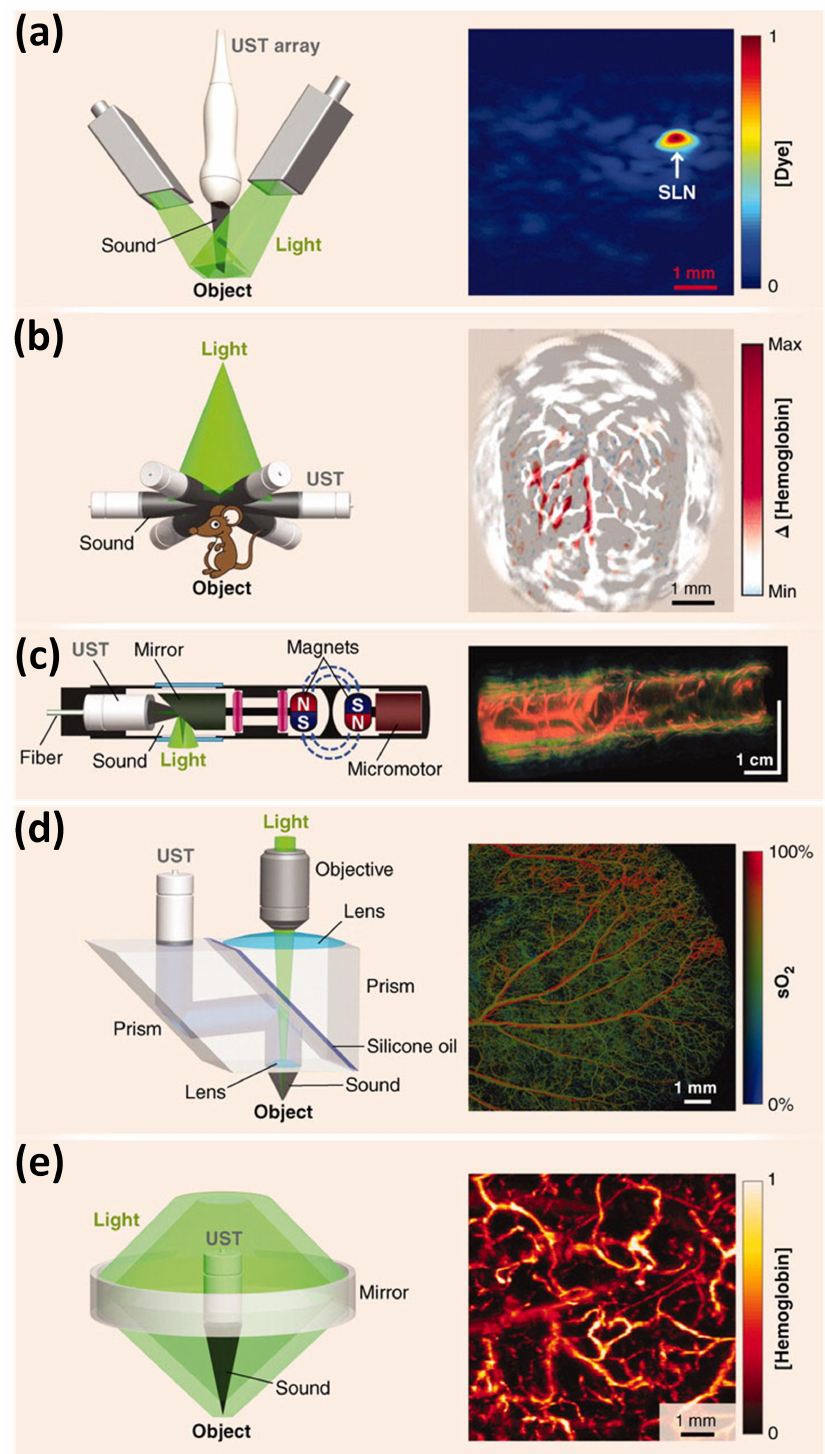
Figure 2. Photoacoustic (PA) imaging system and application in the medical field: ( a ) Linear-array photoacoustic tomography (PAT) of methylene blue concentration in a rat sentinel lymph node (SLN), ( b ) circular array PAT of cerebral hemodynamic changes in a rat, and ( c ) photoacoustic endoscopy (PAE) of a rabbit esophagus. UST: ultrasound transducer. ( d ) Optical resolution photoacoustic microscopy (OR-PAM) used for quantification of oxygen saturation in a mouse ear. ( e ) Acoustic resolution photoacoustic microscopy (AR-PAM) of normalized total hemoglobin concentration in a human palm [16]. Adapted with permission from ref.